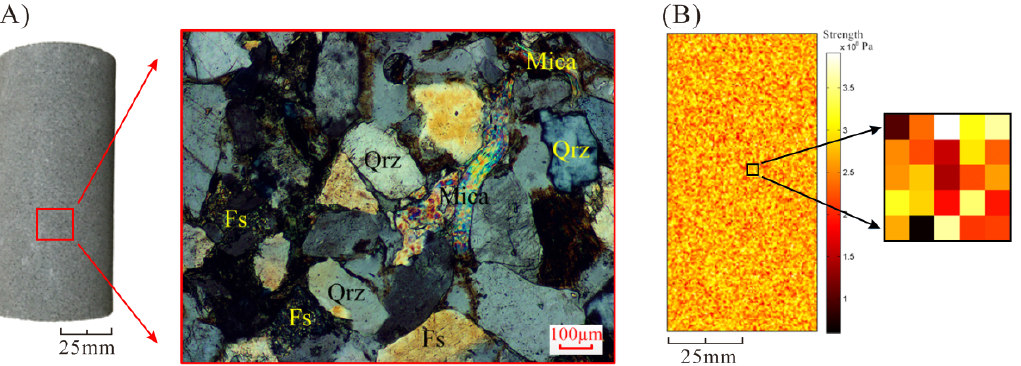
Figure 1. Heterogeneous model of sandstone in the mesoscale. ( A ) Optical microscope image at a 100 µ m scale [45]. ( B ) Heterogeneous distribution of strength elements in the model.